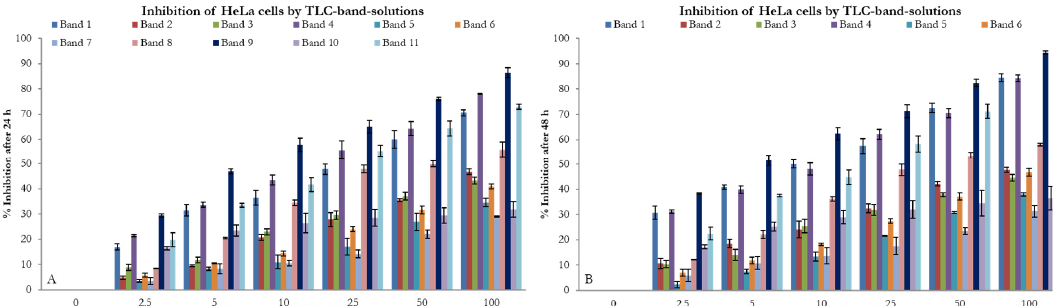
Figure 2. Inhibition of proliferation in HeLa cells exposed to solutions prepared from TLC separated bands of R-Ac extract of A. aspera (A) Inhibition of HeLa cells by TLC-band-solutions - 24 h and (B) Inhibition of HeLa cells by TLC-band-solutions - 48